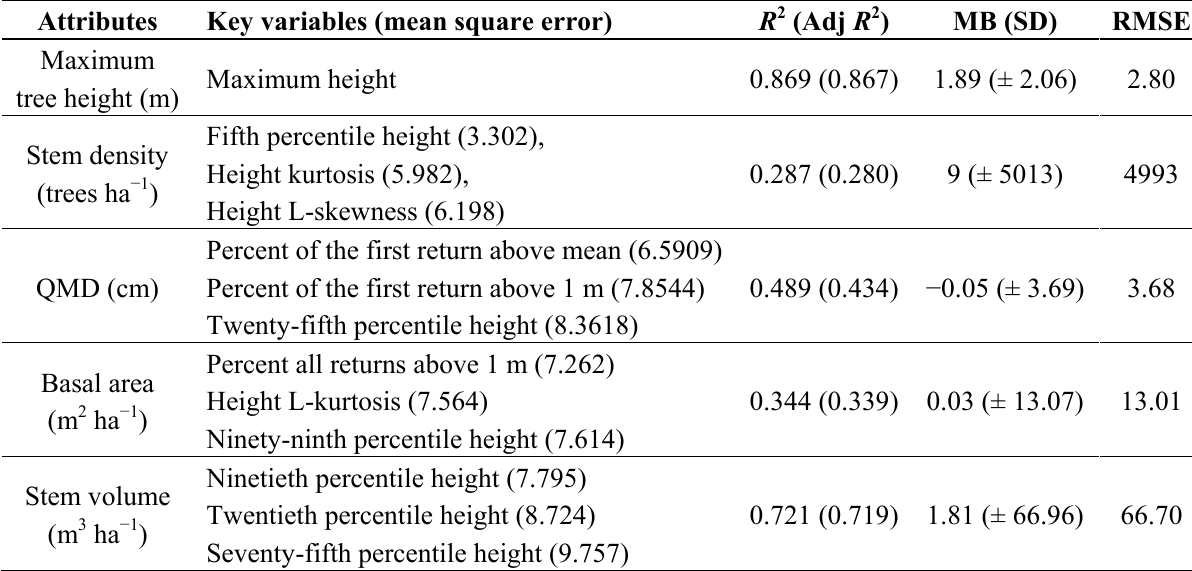
( R 2 ), mean bias (MB) with standard deviation (SD) and root mean square error